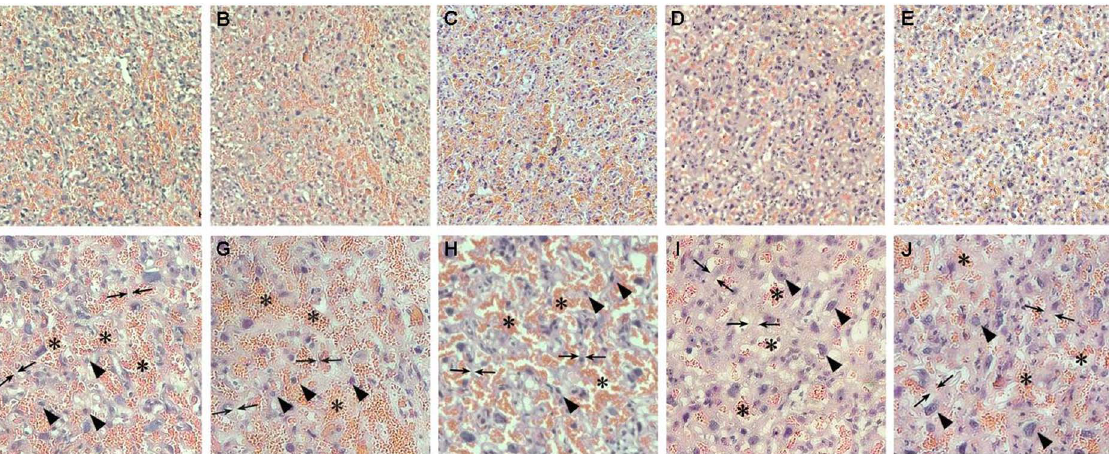
Figure 4. Effects of ITE and TCDD on distribution of RBCs and trophoblastic septa. The representative images of the placental labyrinth zone sections from control (A and F), 1.6 mg/kg bw ITE (B and G), 8.0 mg/kg bw ITE (C and H), 1.6 m g/kg TCDD (D and I) and 8.0 m g/kg TCDD group (E and J) are shown. The sections were subjected to HE staining. Asterisks indicate the maternal sinusoids that are occupied by RBCs, arrowheads indicate the trophoblasts and arrows indicate the trophoblastic septa. Magnification 6 100 (A, B, C, D, E) and 6 200 (F, G, H, I and J).